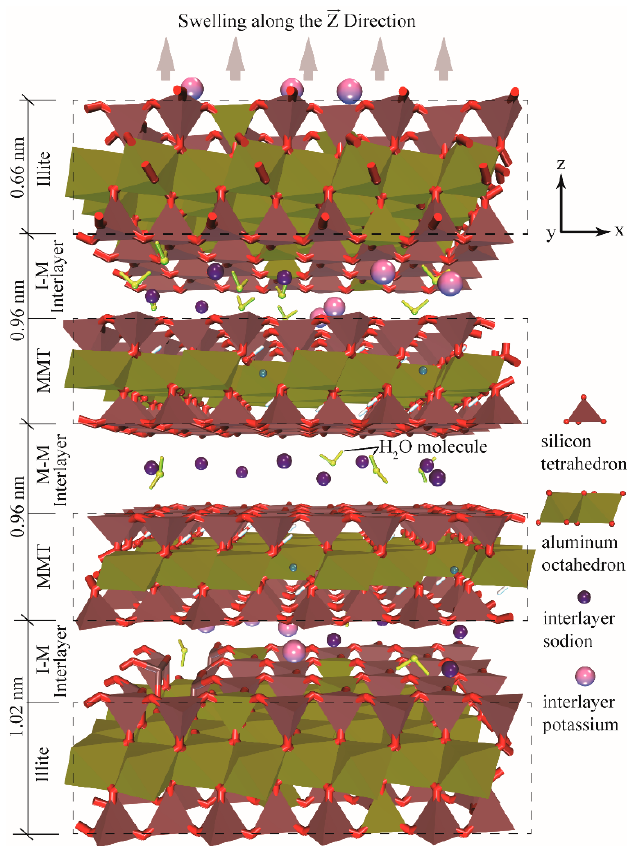
Figure 1. Snapshot of the molecular model of the hydrated mixed layer clay with 50% Na + and 50% K + .